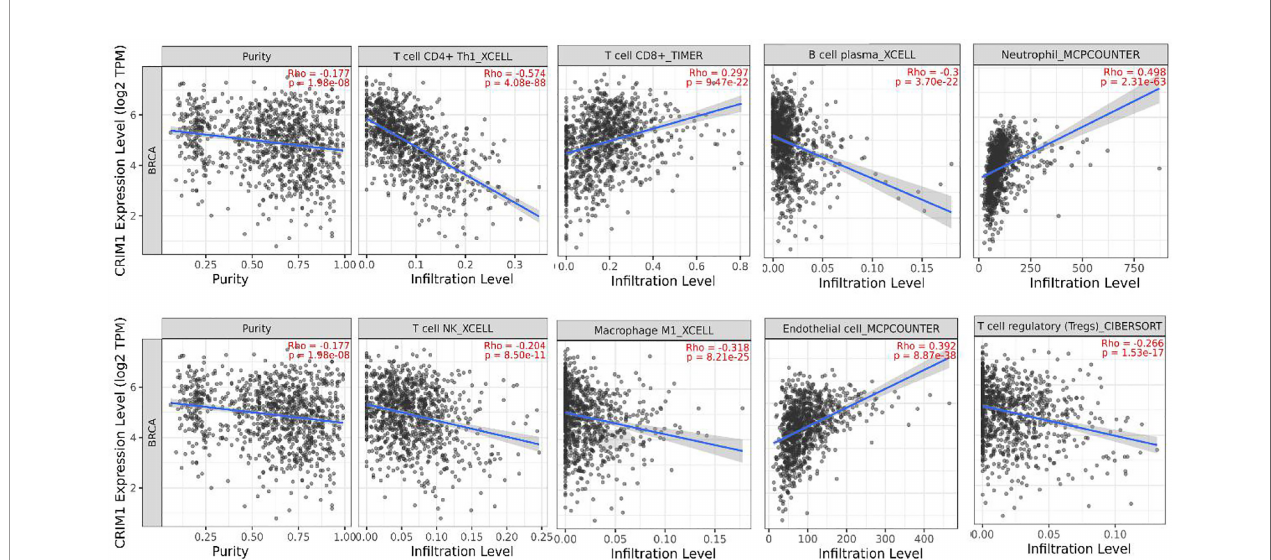
FIGURE 6 | TIMER analysis of the relationship of CRIM1 expression with immune cells invasion levels in breast cancer. CRIM1 expression in breast cancer tissues were negatively correlated with tumor purity, Tregs, NK, B-cells, and CD4 + T-cells, macrophage M1, and positively correlated with CD8 + T-cells, endothelial cells, and neutrophils (n=1100).